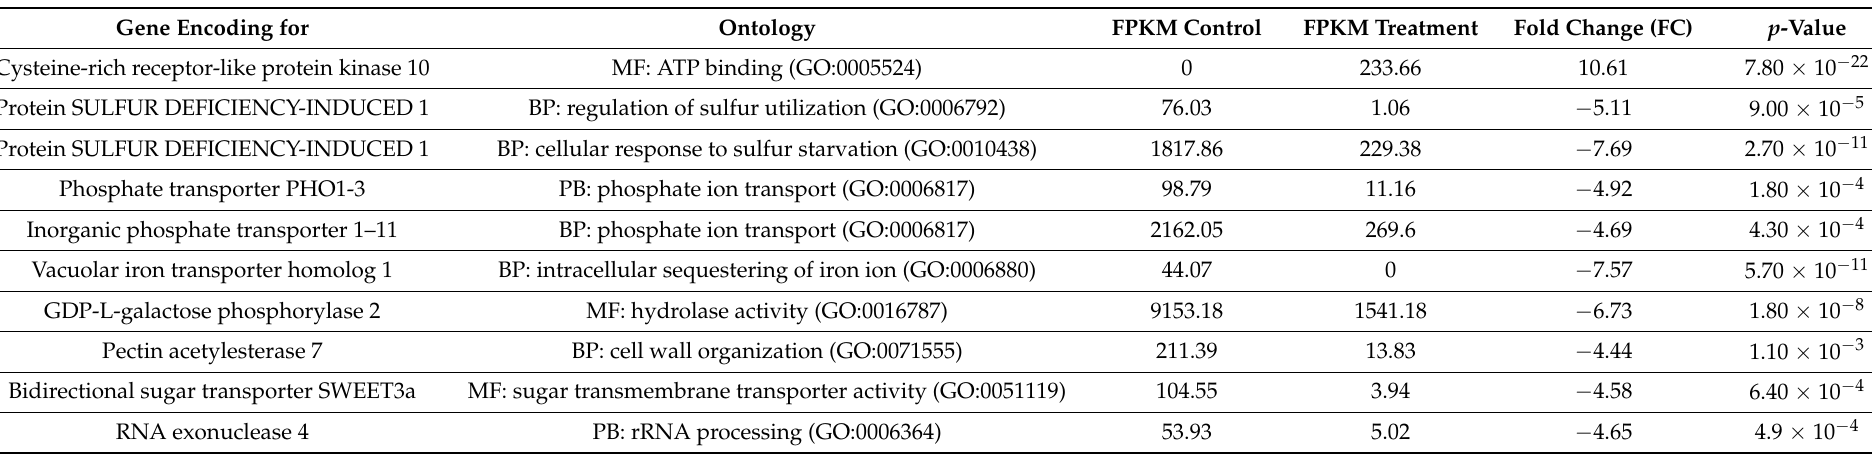
Table 3. Differential expressed genes (DEGs) in shoots of Imperata cylindrica plants growing under Cu stress conditions (300 mg kg − 1 ) with respect to the control condition (without Cu). Gene Encoding for Ontology FPKM Control FPKM Treatment Fold Change (FC) p